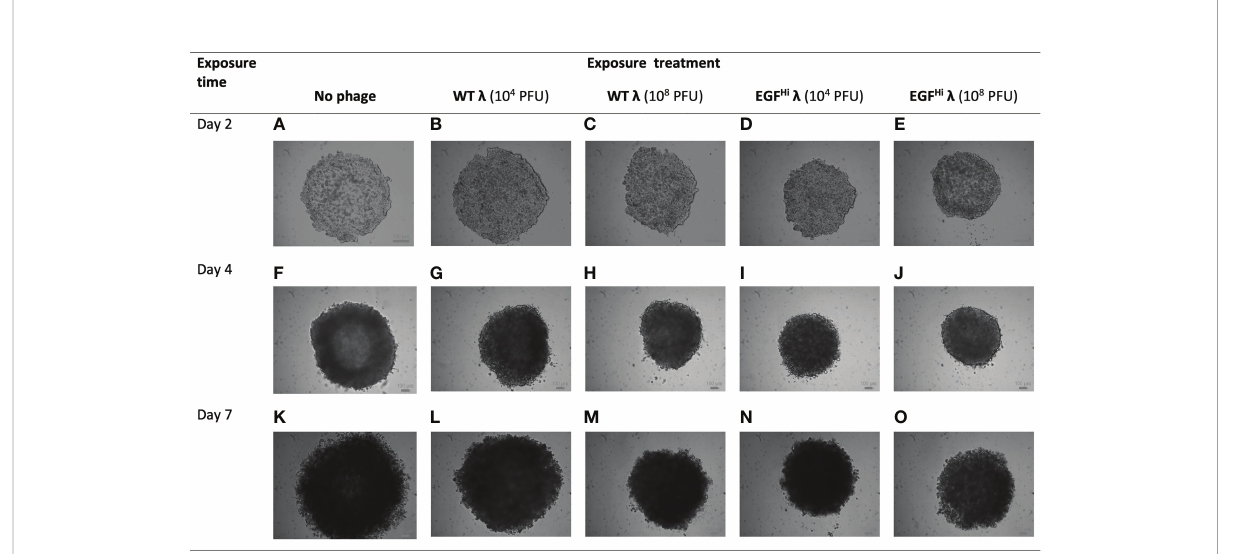
FIGURE 8 Addition of WT l and EGF Hi l particles at initial cell aggregation reduce the size but do not compromise spheroid formation. WT l (B, C, G, H, L, M) and EGF Hi l (D, E, I, J, N, O) phages at two doses (10 4 or 10 8 PFU) were added to the agarose surface at the same time as seeding with HT-29 cells. Initial cell aggregation and resultant spheroid formation were imaged up to d7 with a bright- fi eld microscope, showing full-thickness spheroids and compared to controls (A, F, K) . Representative photographs from one series in 3 independent experiments. Individual scale bars are